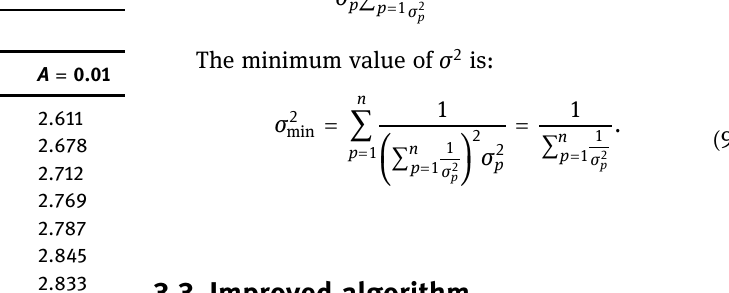
Table 2: Critical value of Grabus criterion ( 2